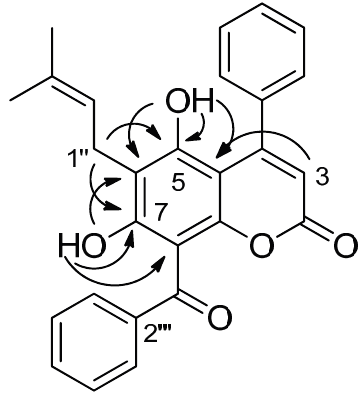
Figure 3. Selected HMBC correlations for iso-pedilanthocoumarin B ( 8